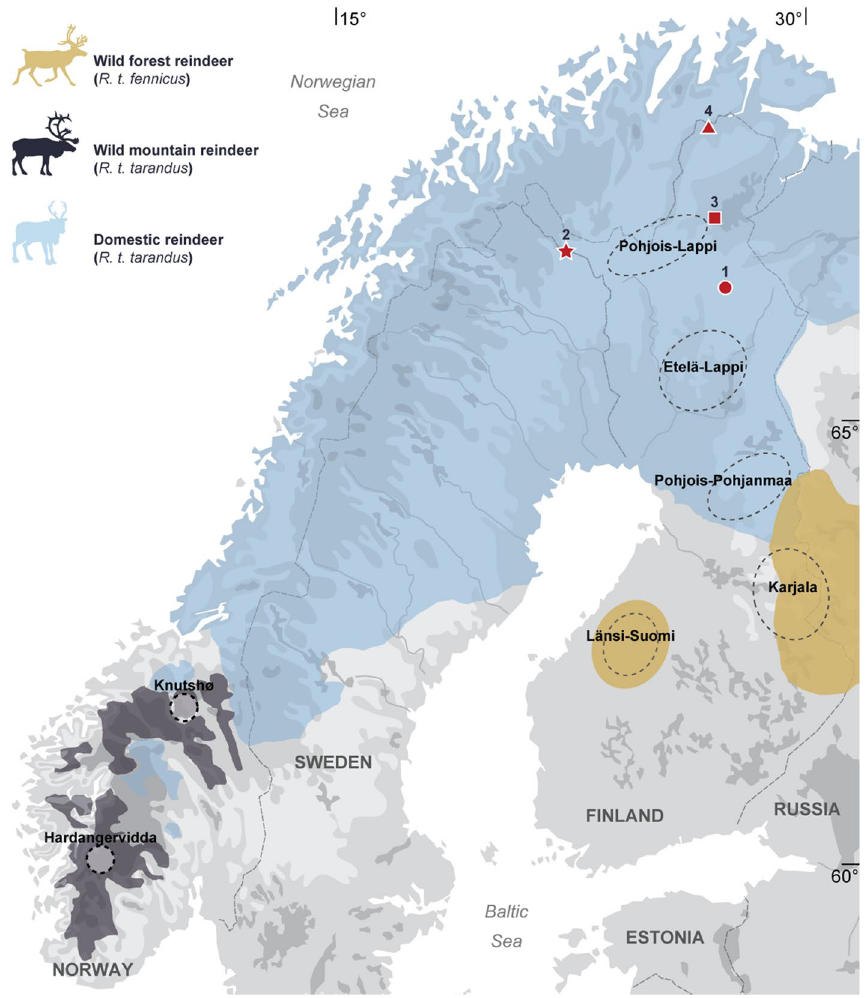
Figure 1. Current geographical distribution of the two reindeer subspecies 19 , including wild and domestic populations in Fennoscandia, with location of the modern populations (wild mountain reindeer: Hardangervidda and Knutshø; wild forest reindeer: Länsi-Suomi and Karjala; domesticated reindeer: Pohjois- Pohjanmaa, Etelä-Lappi and Pohjois-Lappi) and archaeological sites (1: Juikenttä; 2: Markkina; 3: Nukkumajoki; 4: Pappila)